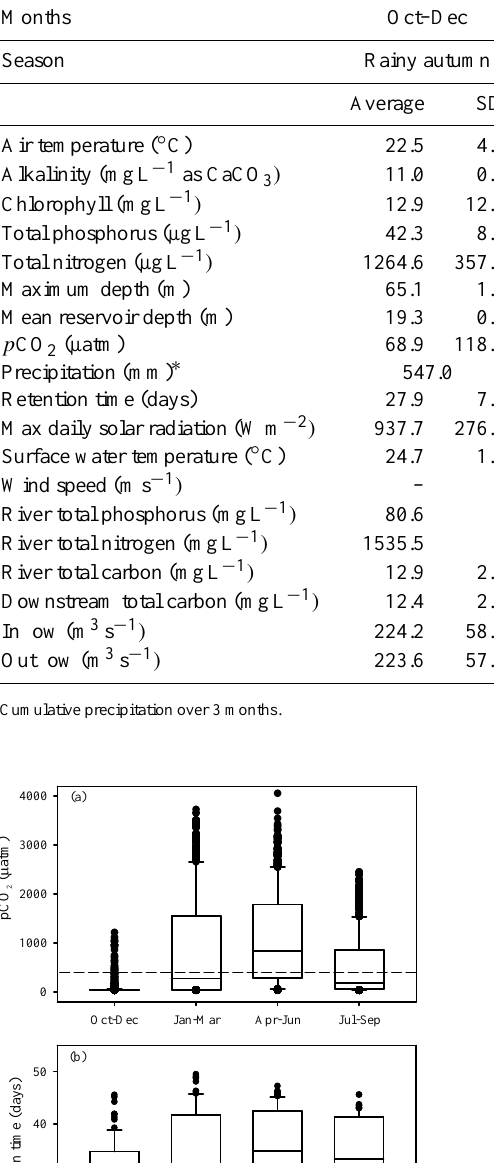
Table 2. Average and standard deviations of environmental and chemical variables from station S28 (near the dam) and river. ∗ Cumulative precipitation over 3 months.